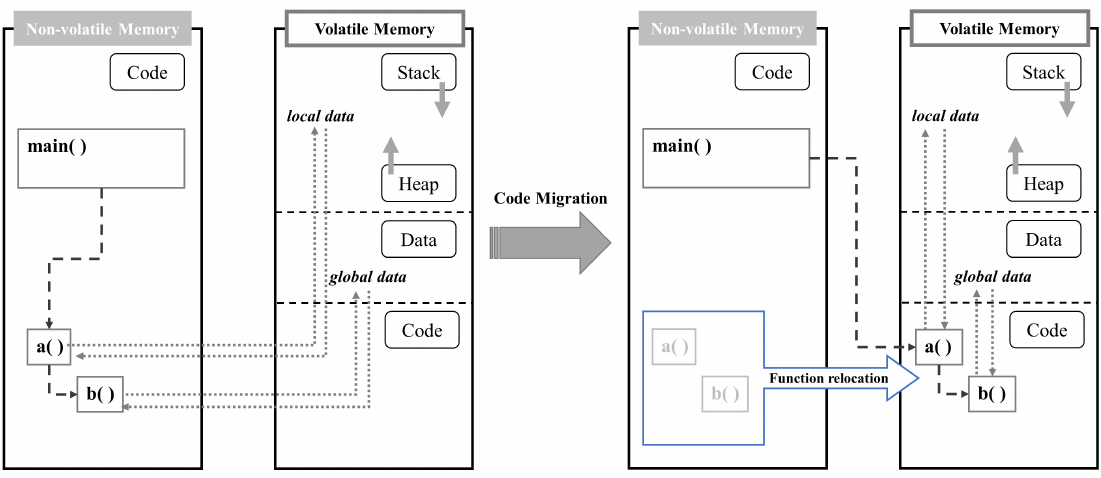
Figure 1. Basic components and processes of code migration